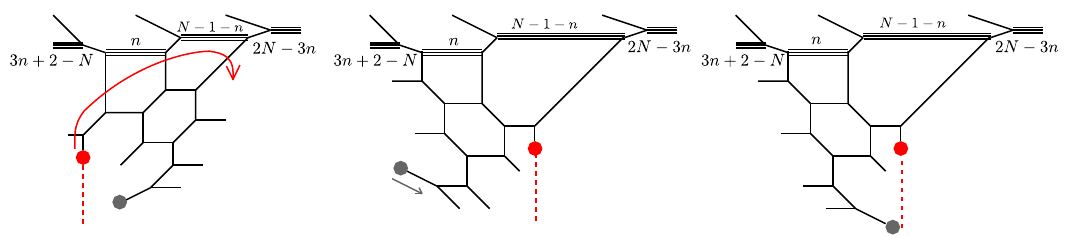
Figure 15 . Derivation of the distribution